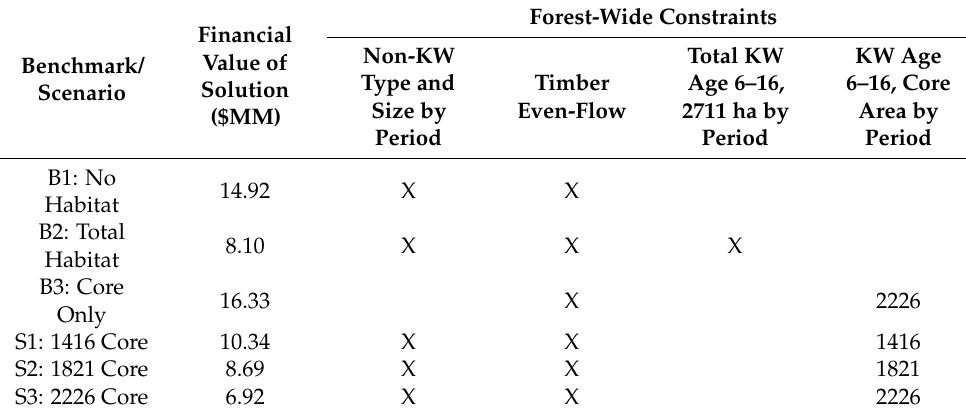
Table 2. Net present value (NPV) estimates for benchmarks and